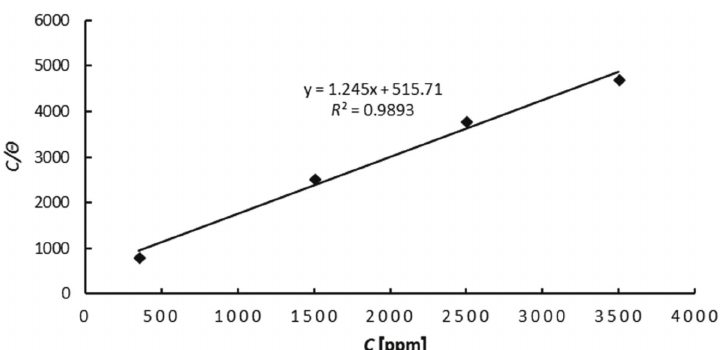
Fig. 4 – Langmuir’s adsorption isotherm for propolis adsorption process on the copper surface in NaCl